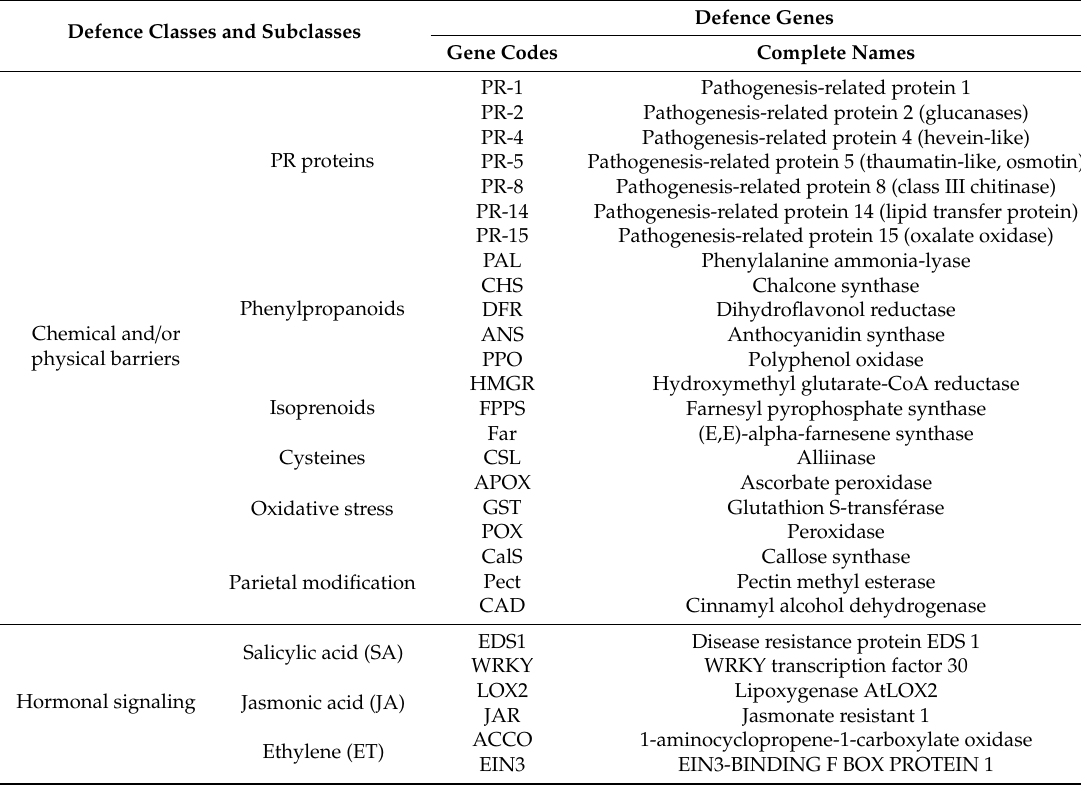
Table 1. List of the plant defense genes studied